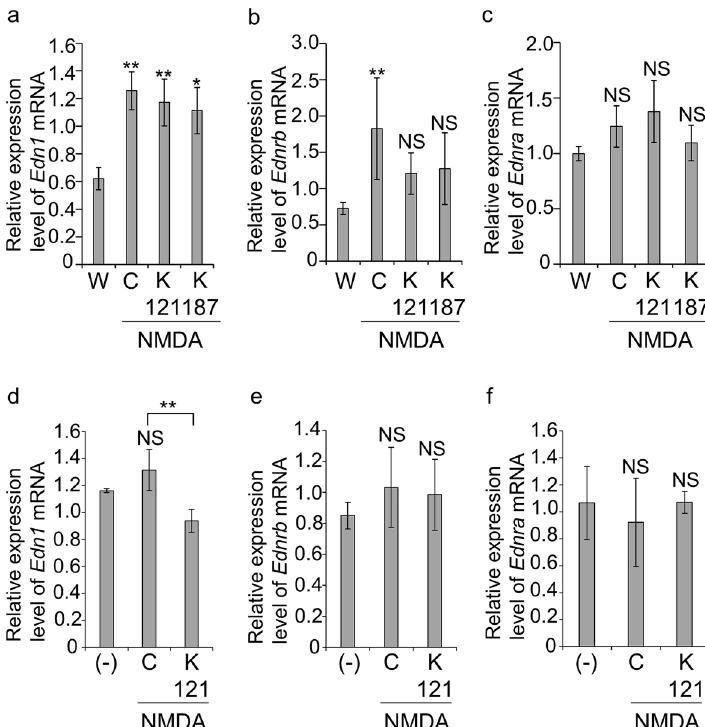
Figure 2. mRNA expressions of endothelin-1 ( Edn1 ), endothelin receptor type A ( Ednra ) and endothelin receptor type B ( Ednrb ) in the mouse retina and primary retinal ganglion cells (RGCs). ( a – c ) Relative mRNA expression in neural retina. Neural retina of non-treated wild-type mice (W, n = 7) and NMDA-injected (C, n = 8), NMDA-injected-KUS121-treated (K121, n = 8) and NMDA-injected-KUS187-treated (K187, n = 8) mice were analyzed. The relative expression levels of Edn1 ( a ), Ednrb ( b ) and Ednra ( c ) mRNA were analyzed using qRT-PCR. The ratios of mRNA expression of each gene to that of glyceraldehyde-3-phosphate dehydrogenase were calculated. * p < 0.05 and ** p < 0.01, vs. W, Tukey’s honestly significant difference (HSD). NS no significant difference compared with W, Tukey’s HSD. ( d – f ) Relative mRNA expression in primary RGCs. Primary